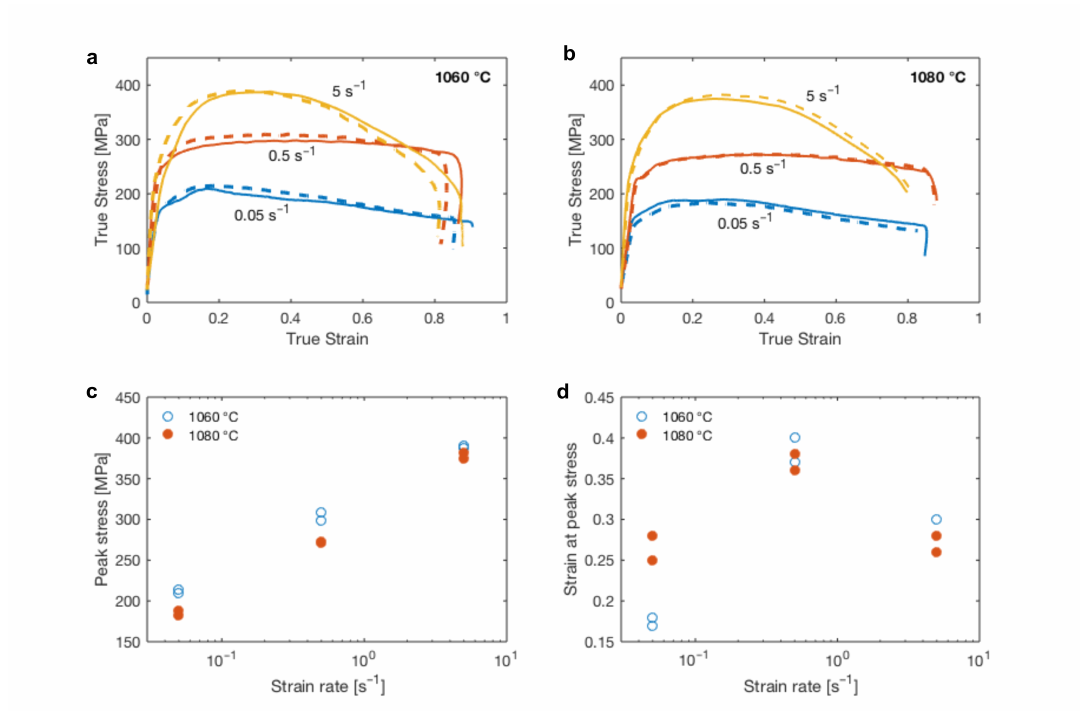
Figure 4. True stress-strain curves for samples deformed at 1060 ◦ C ( a ) and 1080 ◦ C ( b ). Solid lines are for samples that were quenched directly after deformation (Q) and dashed are for the held (H) samples. ( c , d ) Peak stress, σ p and strain at peak stress, (cid:101) p , as functions of strain rate, respectively.